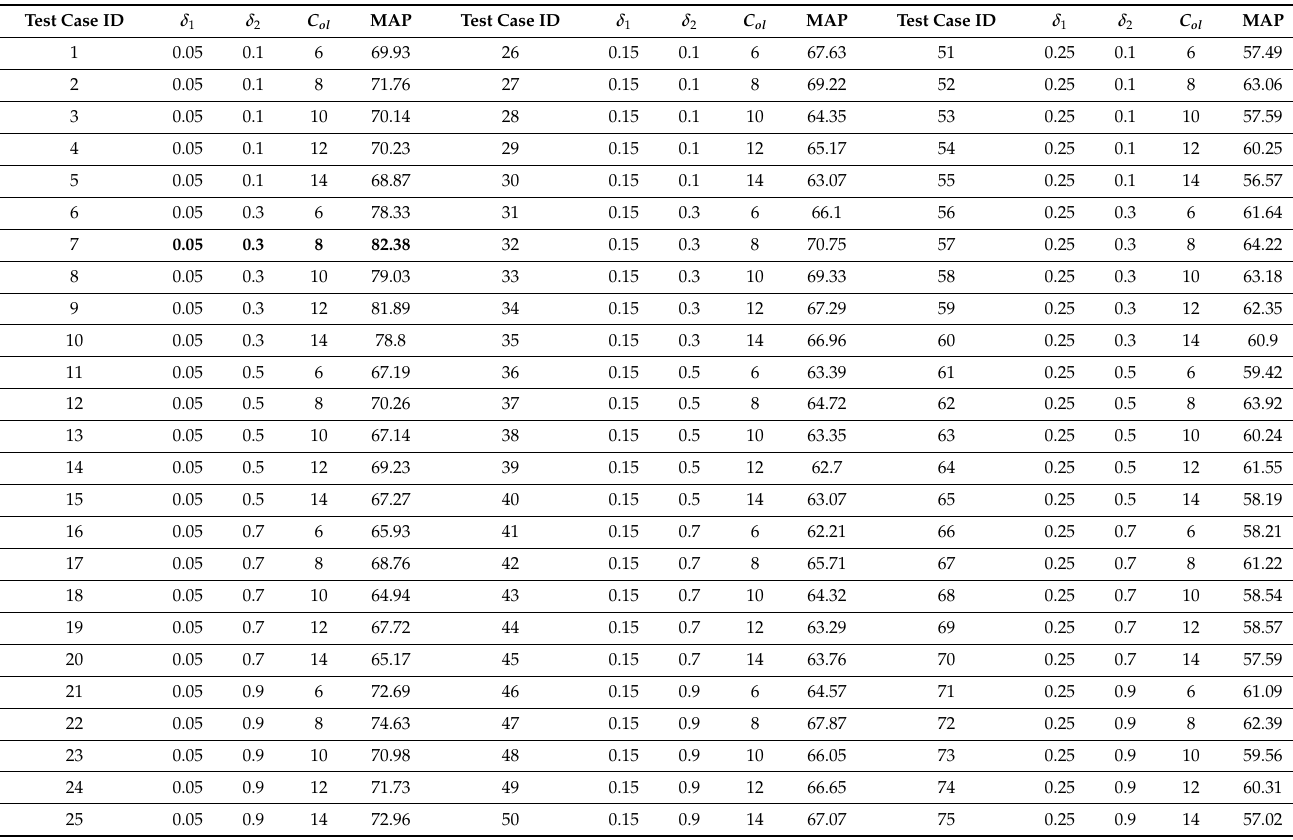
Table 1. Parameter tuning using ablation study to compare the MAP scores against various sets of δ 1 , δ 2 , and C ol . The bold faced numbers represent the best score and values of the parameters- δ 1 , δ 2 , and C ol for which this score is obtained. Test Case